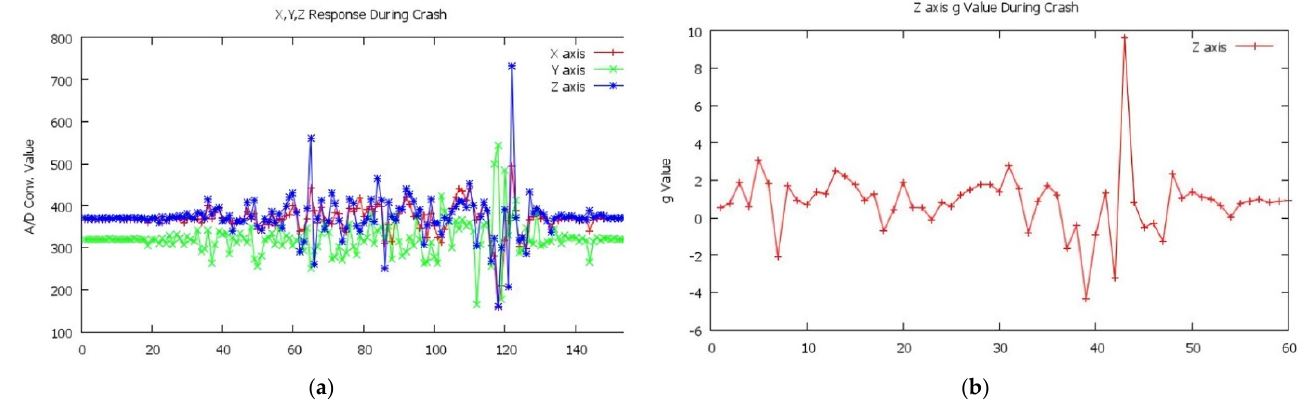
Figure 9. ( a ) Graph of accident test, peak value = 738; ( b ) g value.